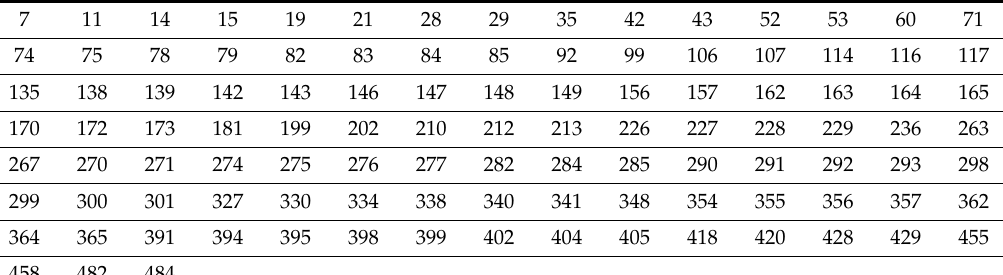
Table 6. x3 corresponding to block R texture template (decimal).